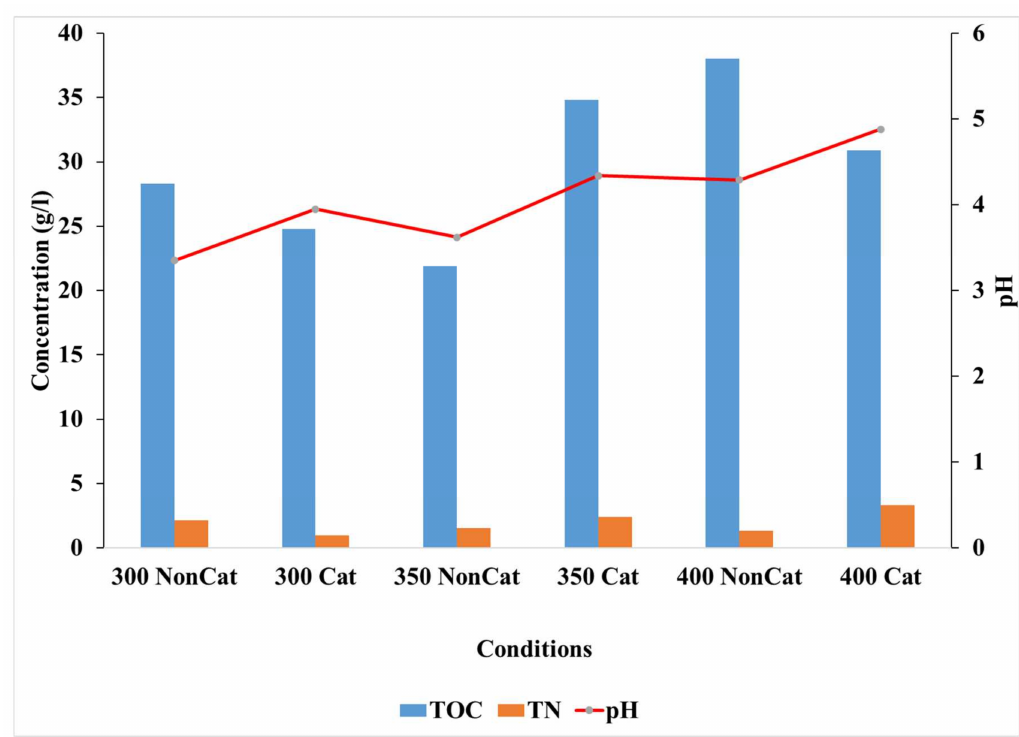
Figure 6. TOC, TN and pH of the aqueous phase.